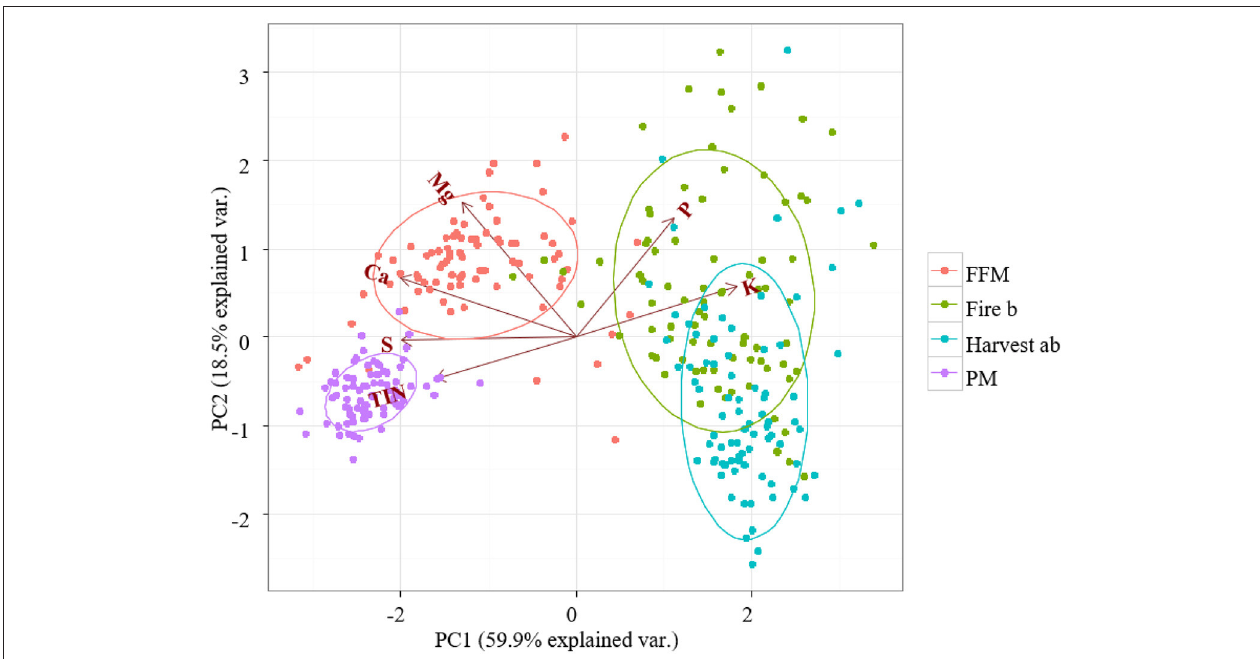
the data ( Figure 3 ). PC1 and PC2 explained 78.4% of the